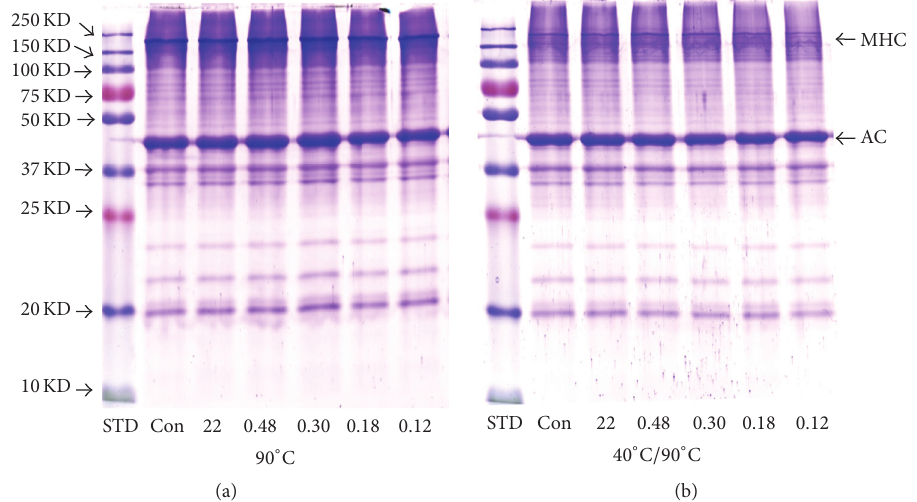
Figure 4: SDS-PAGE patterns of silver carp surimi gels with different size of fish bone particles and thermal treatments. (a) Gel cooked at 90 ∘ C for 30min; (b) gel incubated at 40 ∘ C for 1h followed by 90 ∘ C cooking for 30min. Numbers designate average fish bone particle size ( 𝜇 m). STD: protein standard. Con: control sample, without added fish bone. MHC: myosin heavy chain. AC: actin.